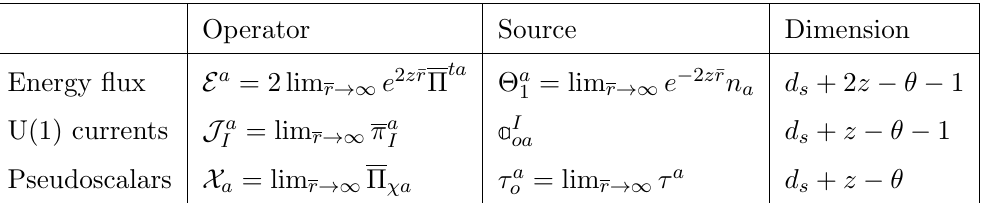
Table 1 . Spectrum of operators corresponding to Dirichlet boundary conditions on all (cid:12)elds.